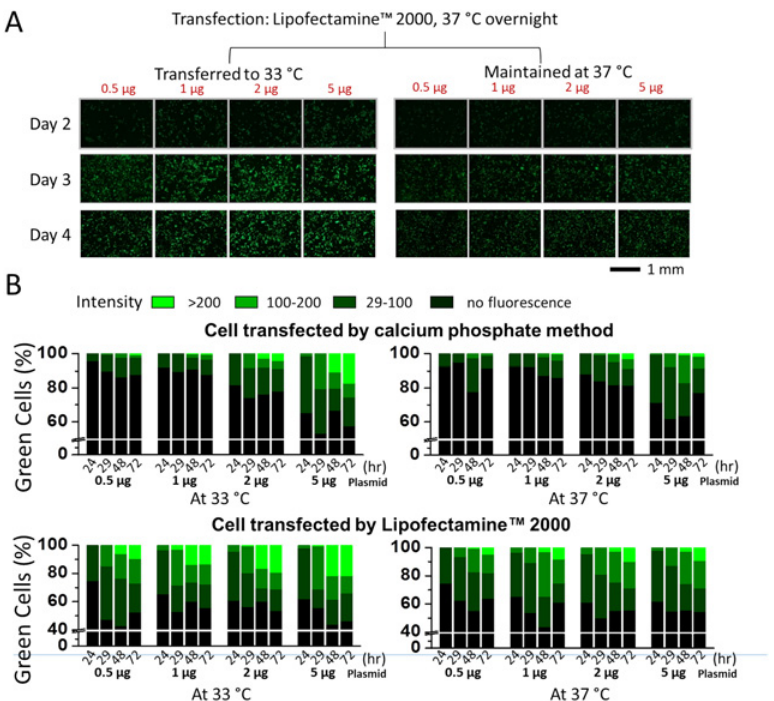
Fig 3. Comparison of different transfection methods and the amount of the GFP plasmid used for transfection. (A) Enhancement of GFP expression in HEK-293S cells that grew at 33°C (on the left), as compared with 37°C (on the right). HEK-293S cells were transfected with varying amounts of the GFP plasmid, as labeled, using Lipofectamine 2000 or by the calcium phosphate method (photos not shown). A set of dishes (on the left) were transferred to a 33°C incubator, 24 hours after transfection and were maintained at 33°C. Shown are green fluorescence images from day 2 to day 4 (8.7x magnification, 1/5 second exposure time). (B) Percentage of the green cells from each of the dishes with varying amounts of the GFP plasmid and the fluorescence intensity from each of three intensity scales. The upper and lower panels are images from cells transfected using calcium phosphate and Lipofectamine 2000, respectively. The images on the right are controls (at 37°C) whereas the images on the left are cells maintained at 33°C (after overnight culture at 37°C). For determining the percentage of green cells, bright-field images for the same dish were also taken (images not shown). In both cases, 34.8x magnification images were used for data analysis. The white colored line represents the line-break. The green cells were further categorized into three levels of brightness. A typical HEK-293S cell in 34.8x magnification contained 3,000 ± 800 pixels. Based on the green fluorescence image, the pixels from the darkest green cell have an intensity of (cid:1) 29. Note the green intensity for each pixel in a JPEG file was recorded in an 8-bit byte, which was converted to a scale from 0 to 255. A cell with the average intensity under 29 indicated no GFP fluorescence, at least not appreciably, which we assigned as black color. A cell with an average brightness between 29 and 100 was labeled low green intensity, colored as dark green bar. A cell with an average brightness between 100 and 200 was considered medium intensity, colored as green. Bright green was the color used to label any cell with an average brightness between 200 and 255. The percentage of each green group was calculated based on the total cell count, and the total number of cells was determined from the bright-field view of the same viewing area (images not